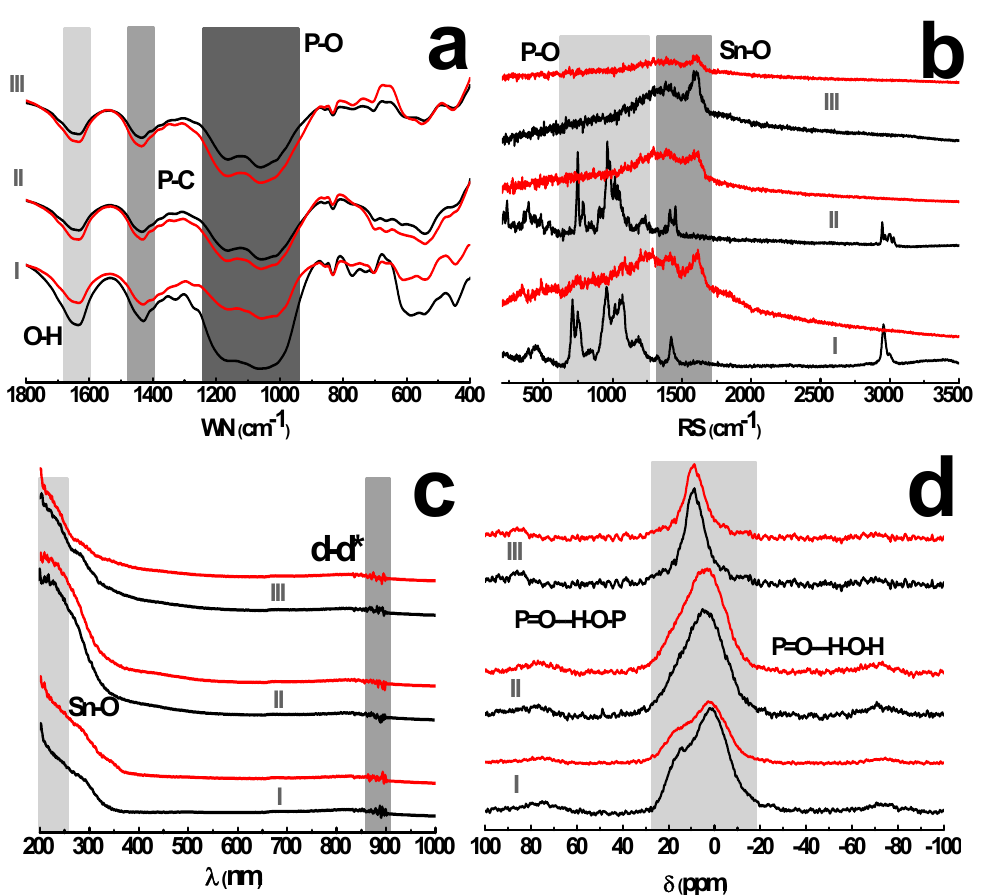
Figure 4. The backbone composition of pristine and leached tin alkylphosphonates: ( a ) Fourier Transform-Infrared (FT-IR) spectra; ( b ) µ -Raman spectra; ( c ) solid UV-Vis spectrum; ( d ) 31 P spectrum. The Sn-ATMP, Sn-EDTMP and Sn-DTPMP are represented by I, II and III, respectively. The WN, RS represents wave number, Raman shift, respectively.